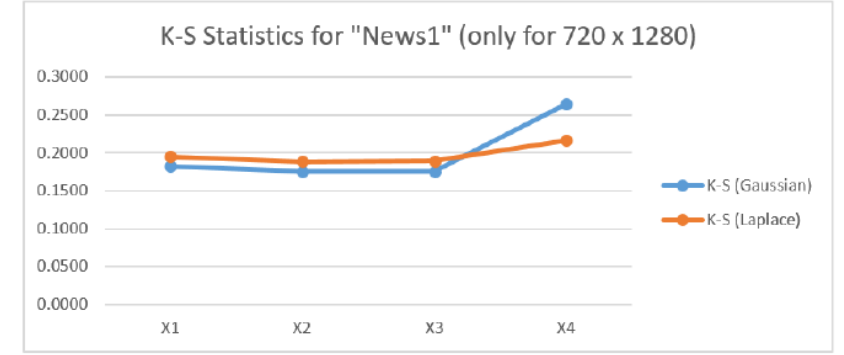
Figure 6. Kolmogorov-Smirnov Test Statistics for News1.